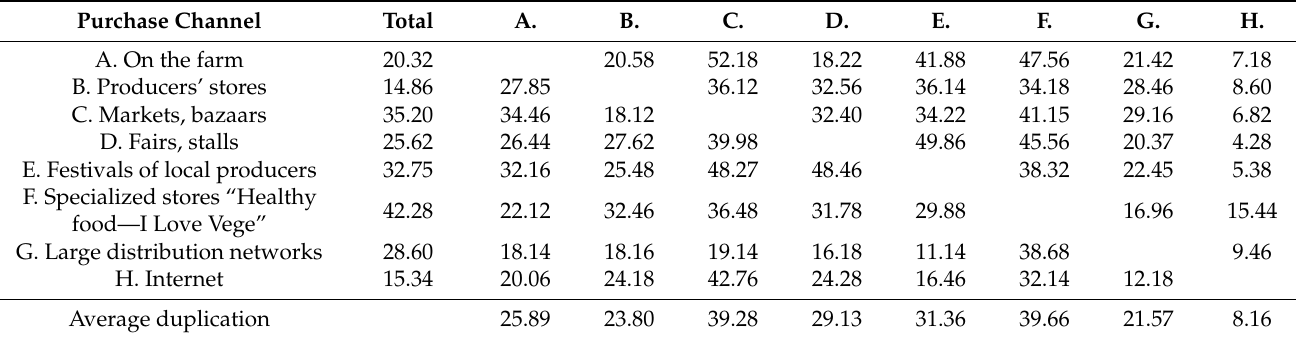
Table 5. Duplicating purchases between selected purchase channels for pulses products among consumers. Purchase